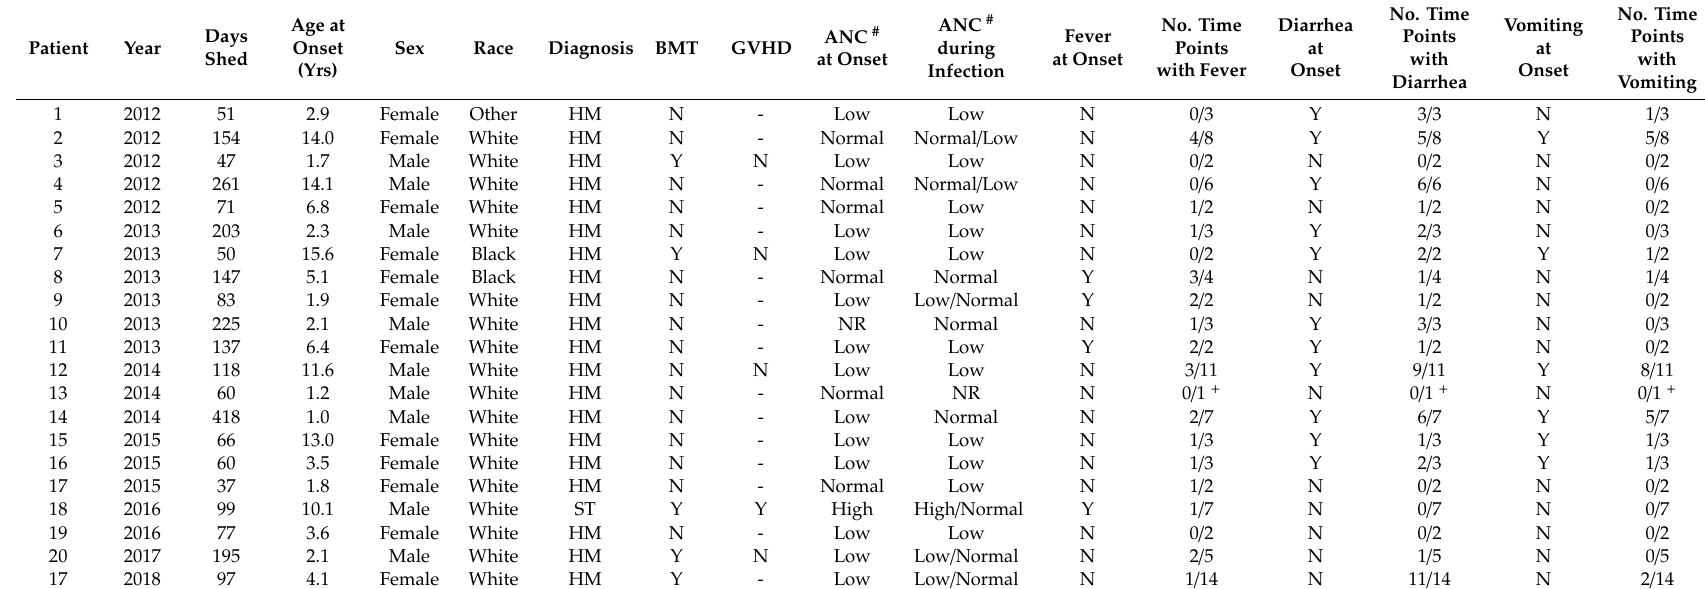
HM, hematologic malignancy; ST, solid tumor; NR, not recorded; # Absolute neutrophil count, low ( < 1500 / mm 3 ), high ( > 8000 / mm 3 ); + No medical record available for the second time